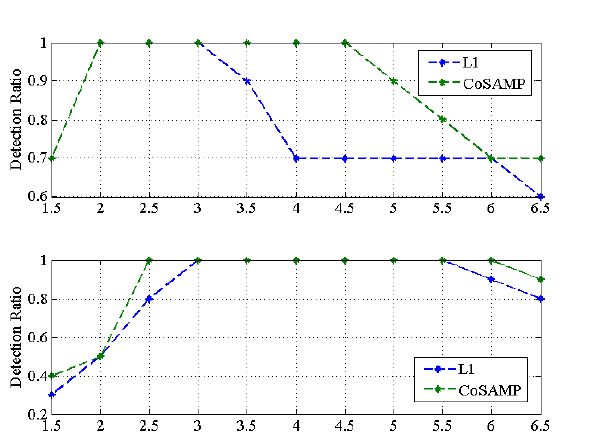
Figure 5. (a) Spread of distribution vs coherence of measurement matrix (b) spread of distribution vs average received